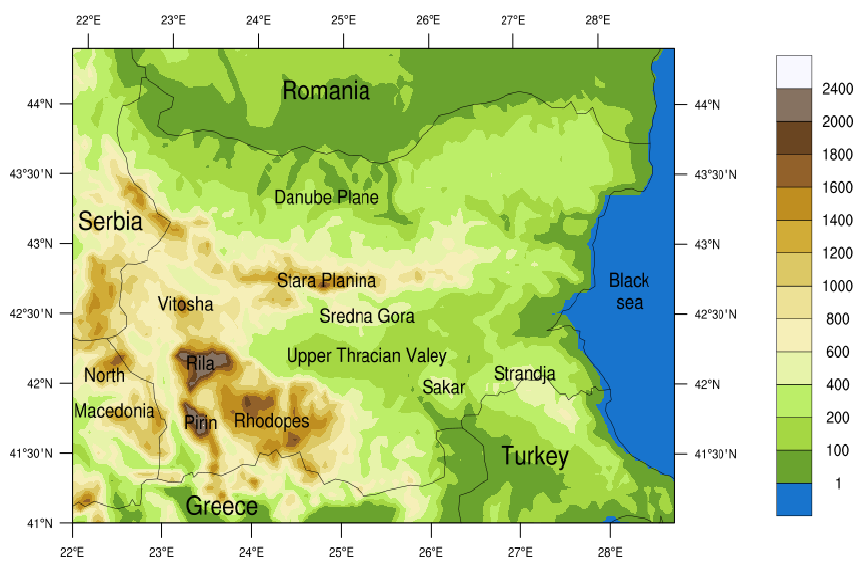
Figure 1. Topography of the domain over which lightning activity based on ATDnet data for the period 2012–2021 is